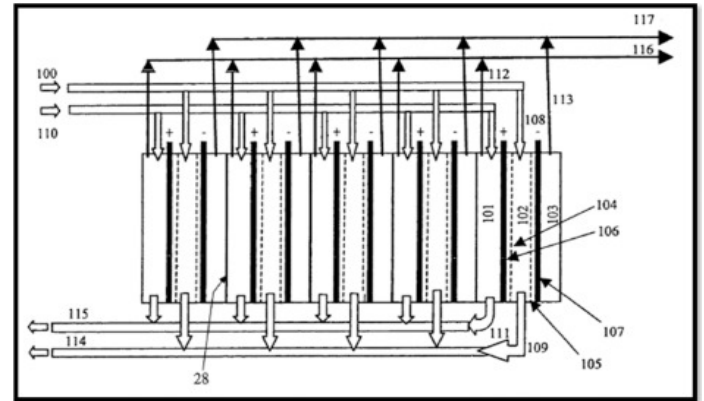
Figure 3. The principle of electrodialysis cell used in continuous process [1]. Table 3. Different electrocoagulation techniques for removing